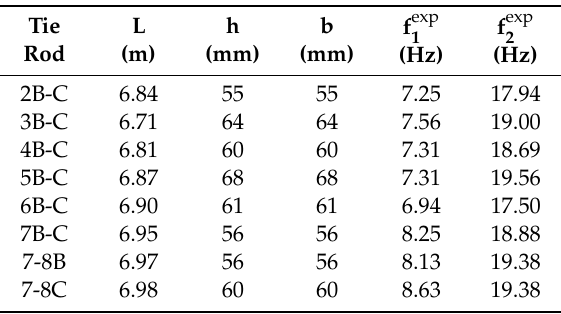
Table 2. Values of the first two frequencies of experimentally-observed tie rods in the Cathedral of St. James in Šibenik at level R4.